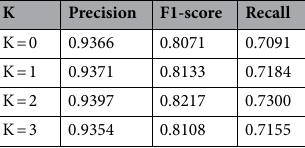
Table 1. Experiments on the effectiveness of data enhancement